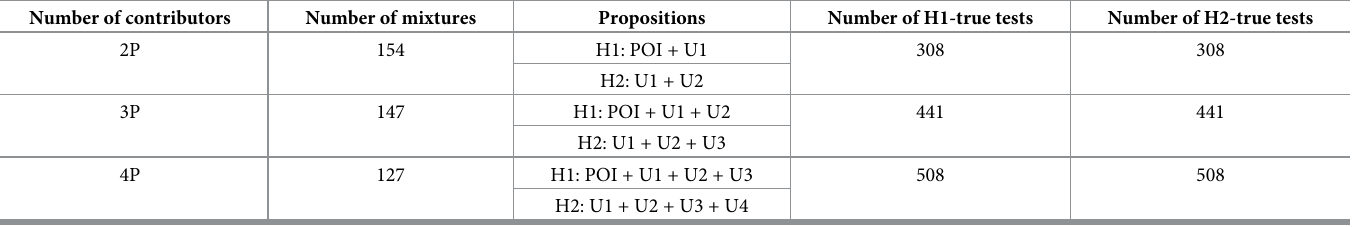
Table 2. Summary of the total number of PROVEDIt mixture profiles and H1-true and H2-true propositions analyzed in both STRmix and EFM for 2P, 3P, and 4P